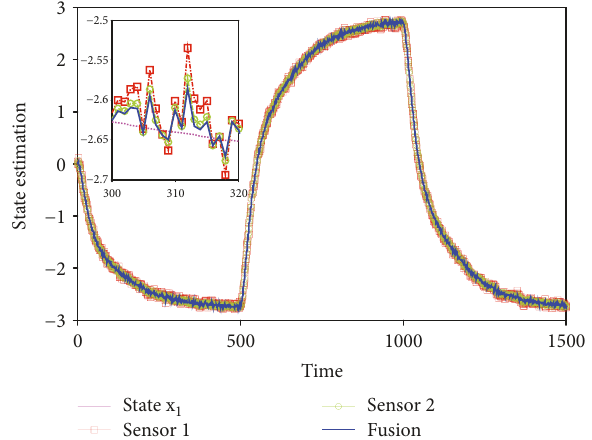
Figure 8: The error of x 2 estimation (sensor 1, sensor 2, and fusion) ( L =200).